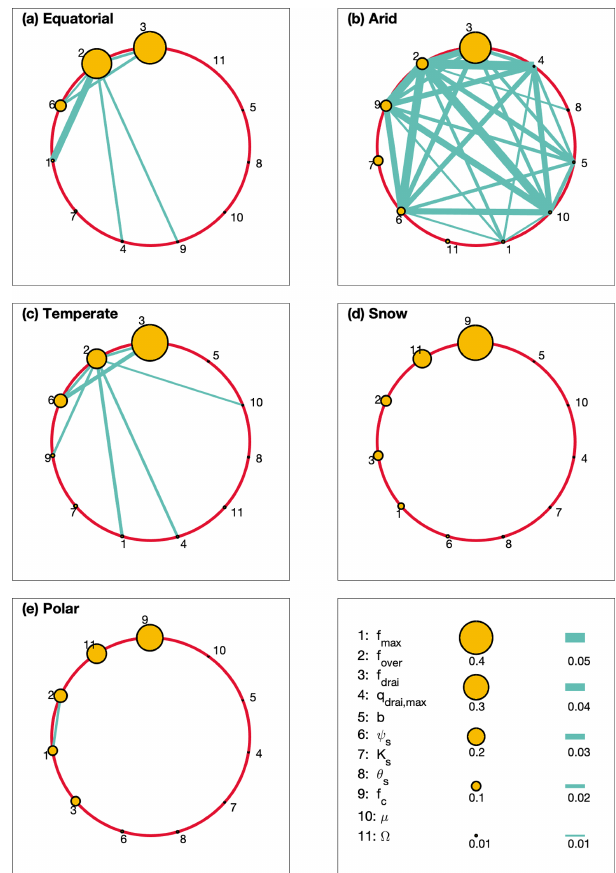
Figure 5. Averaged main Sobol’ index and joint Sobol’ index for different climates defined by the Köppen climate classification. Only the cells with the relative norm 2 errors of PCE-based sur- rogate models for validating simulations of less than 0.15 are used for estimating the averaged sensitivity for each climate region. The size of the circles and thickness of the lines are proportional to main Sobol’ index and joint Sobol’ index, respectively. The legend in the right bottom subplot shows the Sobol’ index for the corresponding size of circle and thickness of